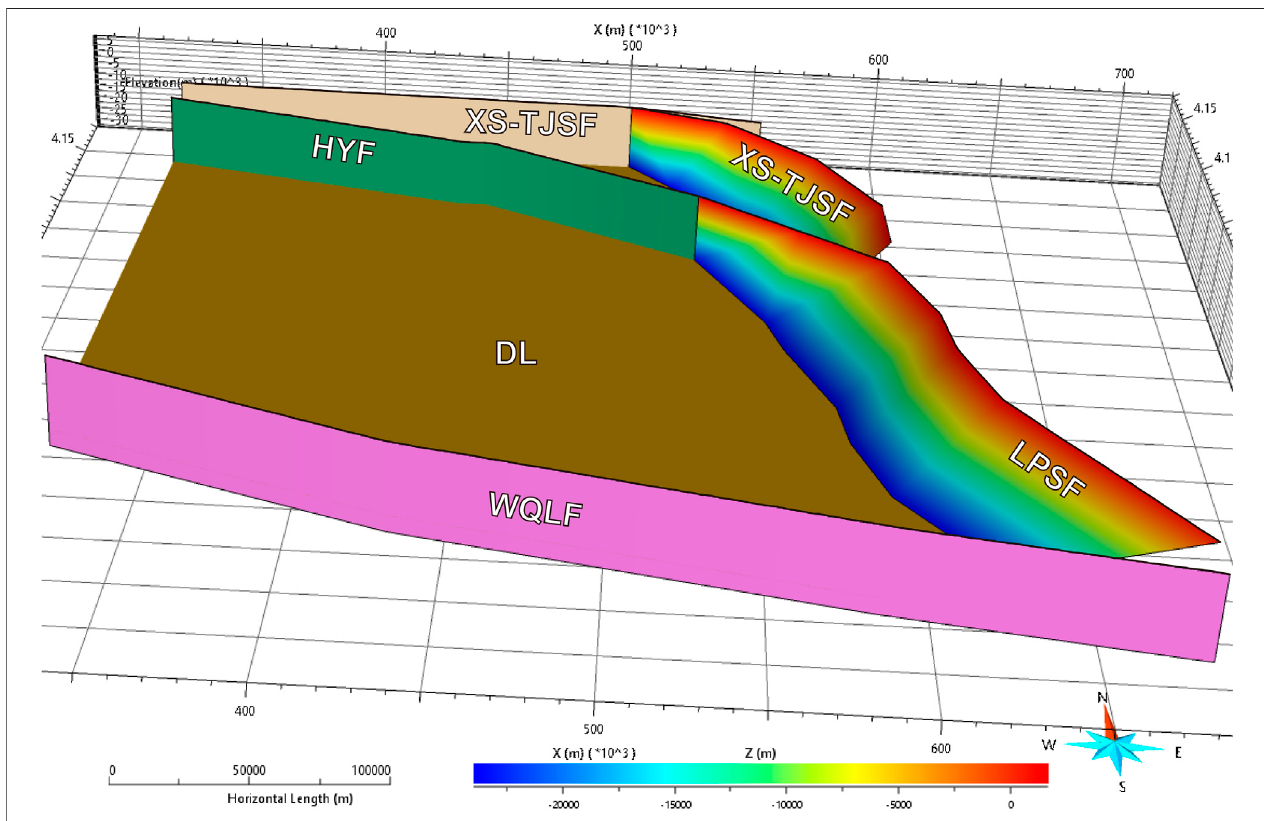
FIGURE4| Sideviewoftheinitial3DfaultmodelV1oftheactivefaultsinthearc-shapedtectonicbeltinthenortheasternmarginoftheTibetanPlateau.Thecolorof thrust faults varies with depth, and the left-slip faults are indicated by a single color (The fault colors in Figure 6 and Figure 7 have the same meaning). DL, detachment layer of 24 km